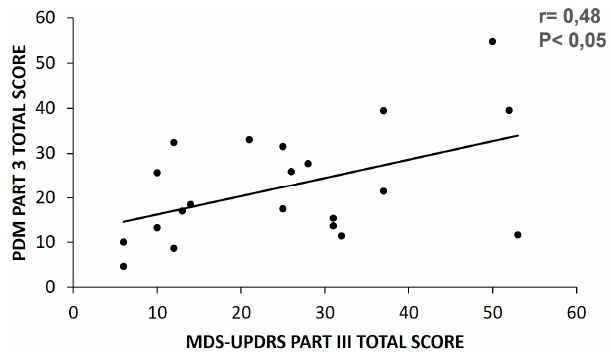
Figure 8. Correlation plot of the total part III score between the clinical scale and the PDMonitor ® (PDM dUPDRS part III).